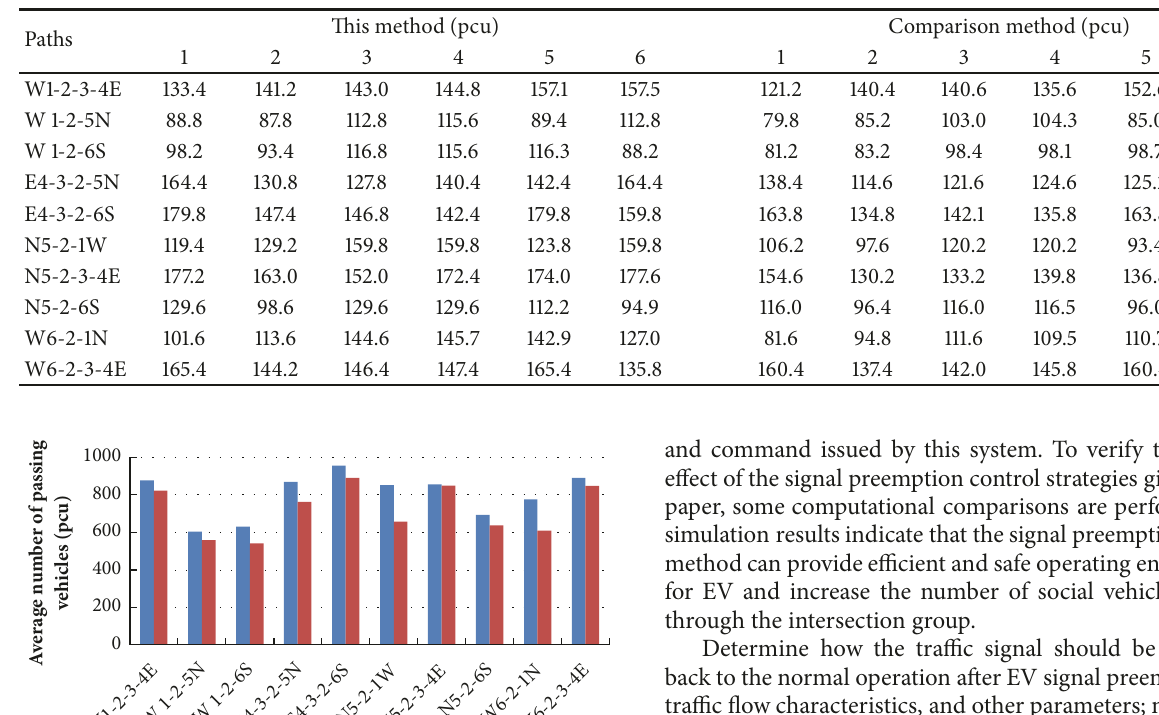
Table 3: The number of social vehicles passing through each intersection.